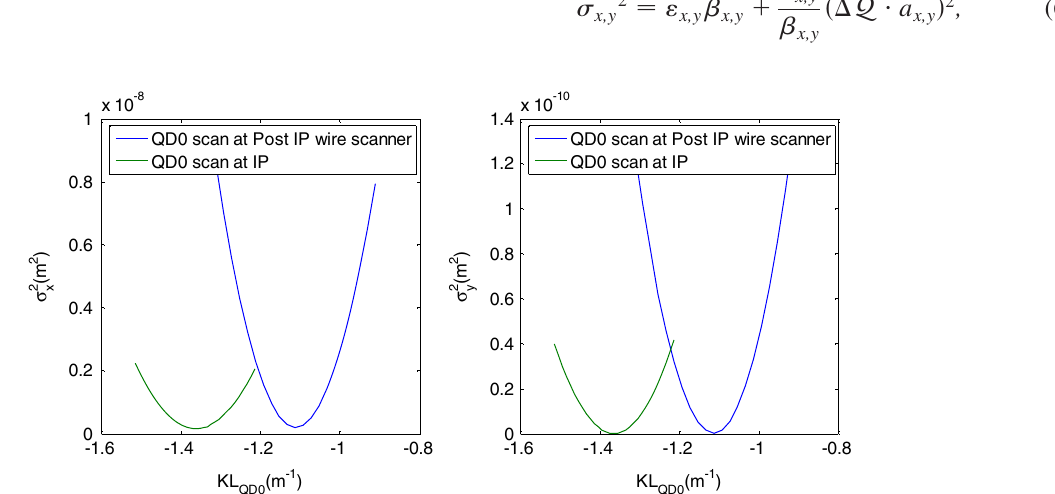
FIG. 5. Simulated beam size squared with respect to QD0 strength in the (cid:1) x=y ¼ 0 : 08 = 0 : 01 m ATF2 optics, when focusing the beam to a waist at the IP (green curves) or post-IP (blue curve)